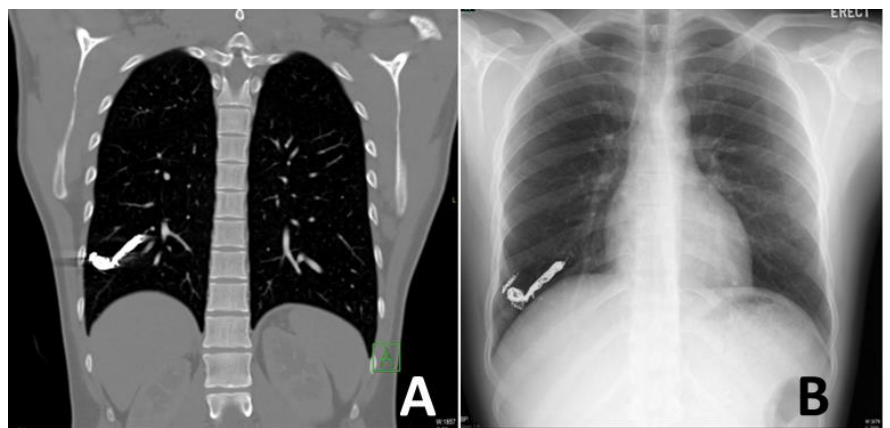
Figure 4. Three-month follow-up imaging of the patient treated in Figure 3. The patient was well with no residual shortness of breath. His saturation on room air also increased to 98%. The coronal contrast-enhanced computed tomography ( A ) and posterior-anterior chest radiograph ( B ) demonstrate the tightly packed coils with no evidence of flow recurrence or any new complications.